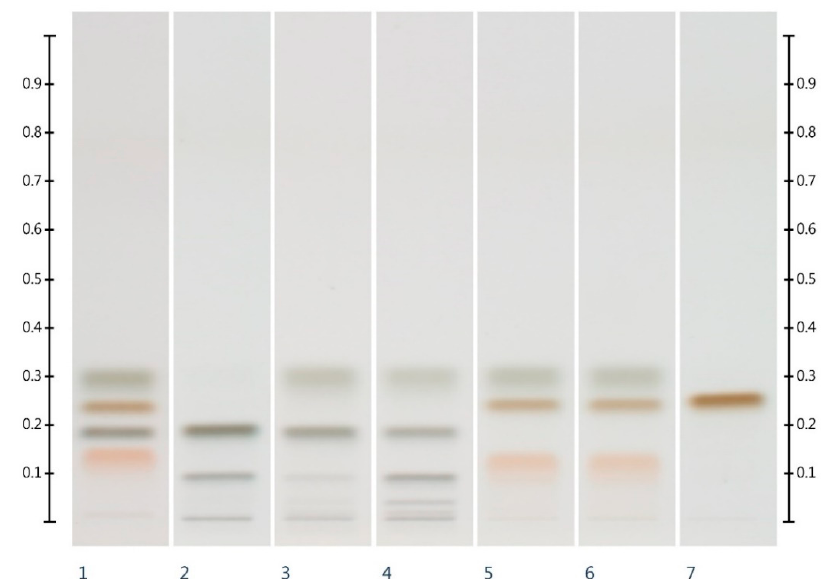
Figure 2. HPTLC images taken at T White light after derivatisation with aniline-diphenylamine- phosphoric acid reagent; Track 1—Standards (fructose, maltose, sucrose and glucose in increasing Rf values), Track 2—COR, Track 3—RIC, Track 4—GLU, Track 5—GOL, Track 6—TRE, Track 7—MAP; Tracks 2–7 were obtained with a 3 µL aqueous methanolic syrup solution.